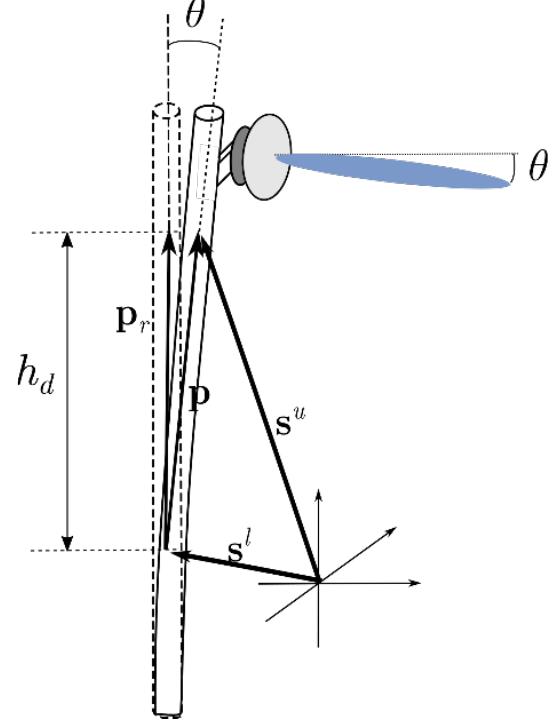
Figure 6. 3D inclination angle measurement diagram. Table 2. Values of parameters for the calculation of inclination angle due to wind speed. Symbol C 1 A 1